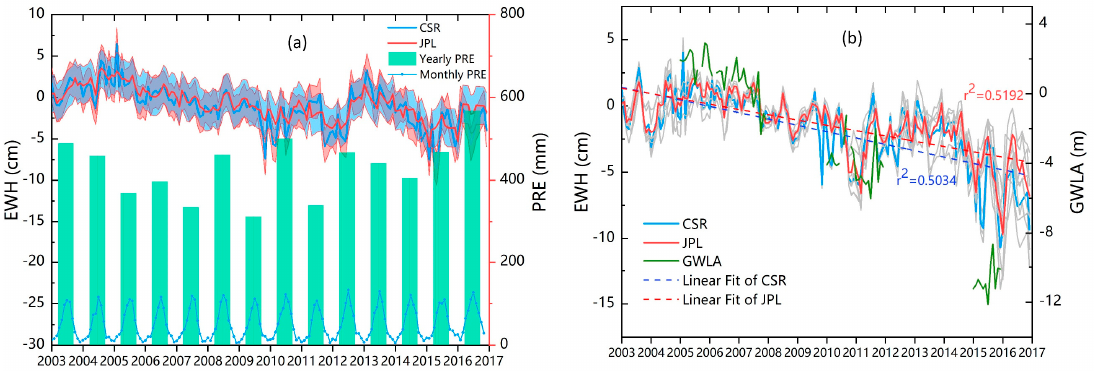
Figure 3. Time series of water storage changes from 2003 to 2016. ( a ) shows the monthly TWSA (derived from CSR and JPL) and yearly PRE from 2003 to 2016; ( b ) shows the time series of GWSA derived from GRACE and GLDAS. GWLA: groundwater level anomalies; JPL: Jet Propulsion Laboratory; PRE: precipitation; CSR: Center for Space Research; EWH: Equivalent Water Height.